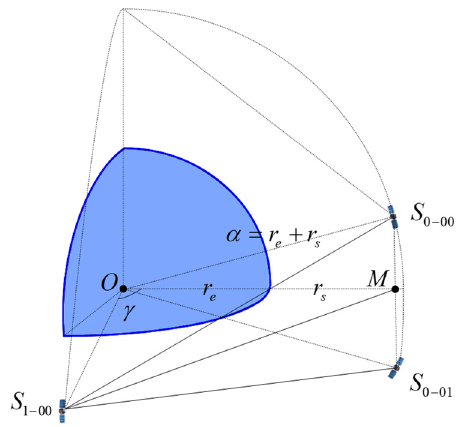
Figure 8. ISL has the longest communication distance between adjacent orbital planes.